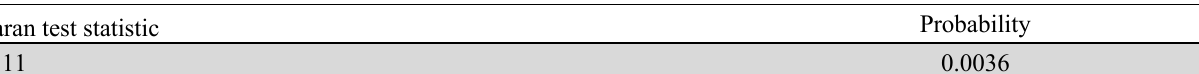
Pesaran’s test Pesaran test statistic